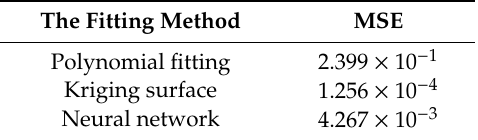
Table 3. The Mean Square Error value of three